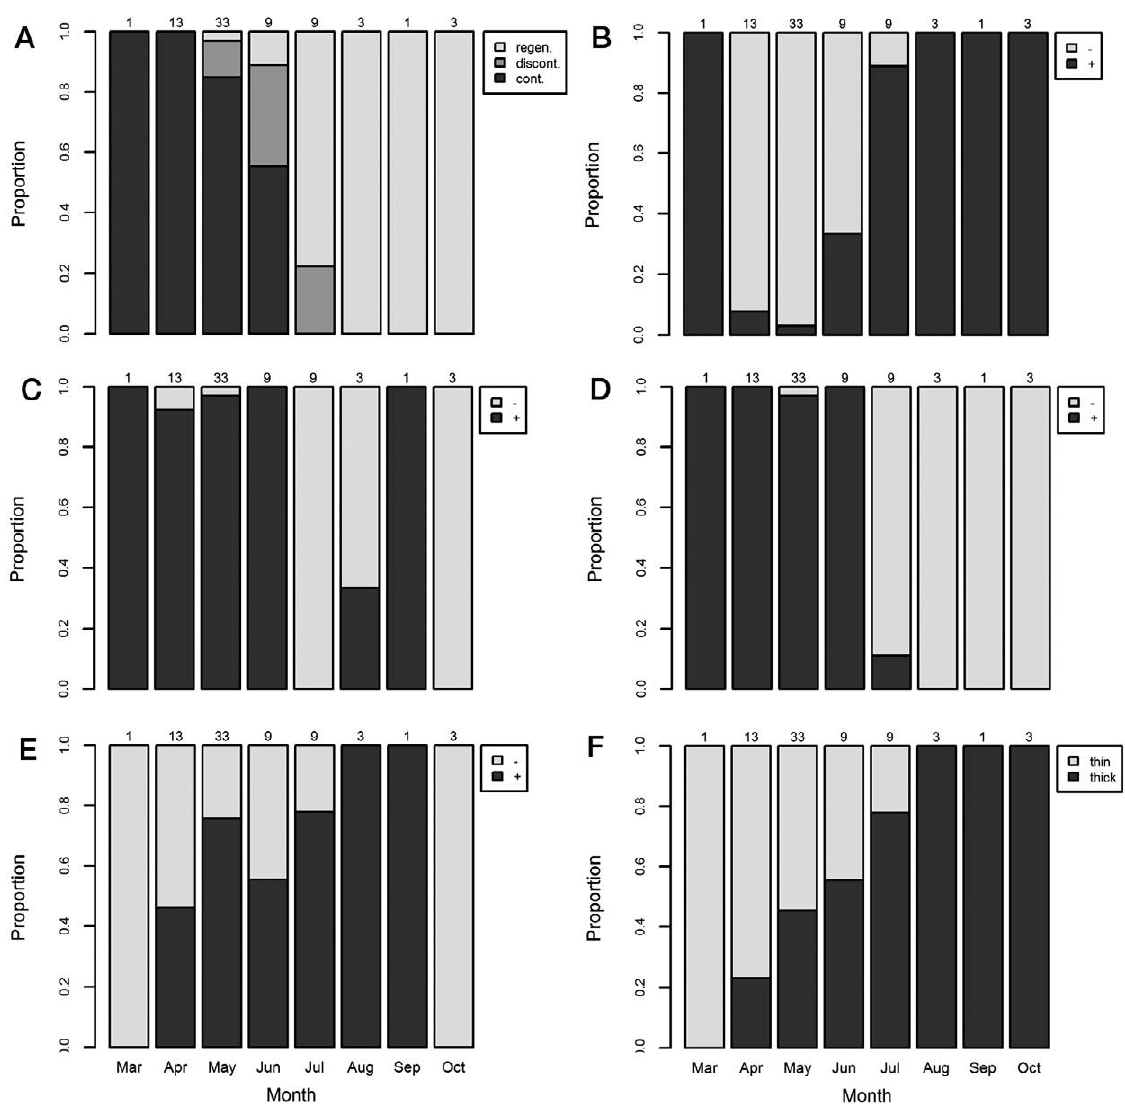
Fig. 5. – Month-related variations in the histologic characteristics of the testes of mature meagre (>80 cm; Tixerant 1974). y -axis represents the proportion of monthly samples that showed each feature. A, germinal epithelium structure (cont., continuous; discont, discontinous; regen., regenerated); B, primary spermatogonia; C, primary spermatocytes; D, spermatids; E, spermatozoa; F, tunica thickness. “+”, abundant or very abundant, “-”, not abundant or absent. Numbers above bars are sample